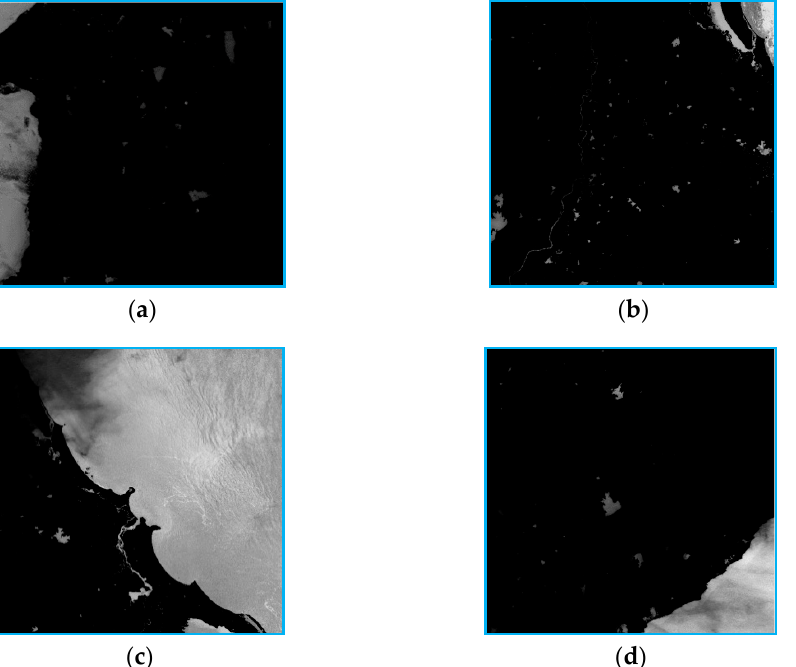
Figure 15. Results of HRnet network: ( a ) short coastline; ( b ) long coastline; ( c ) multiple coastlines; and ( d ) cloud-sheltered coastline.